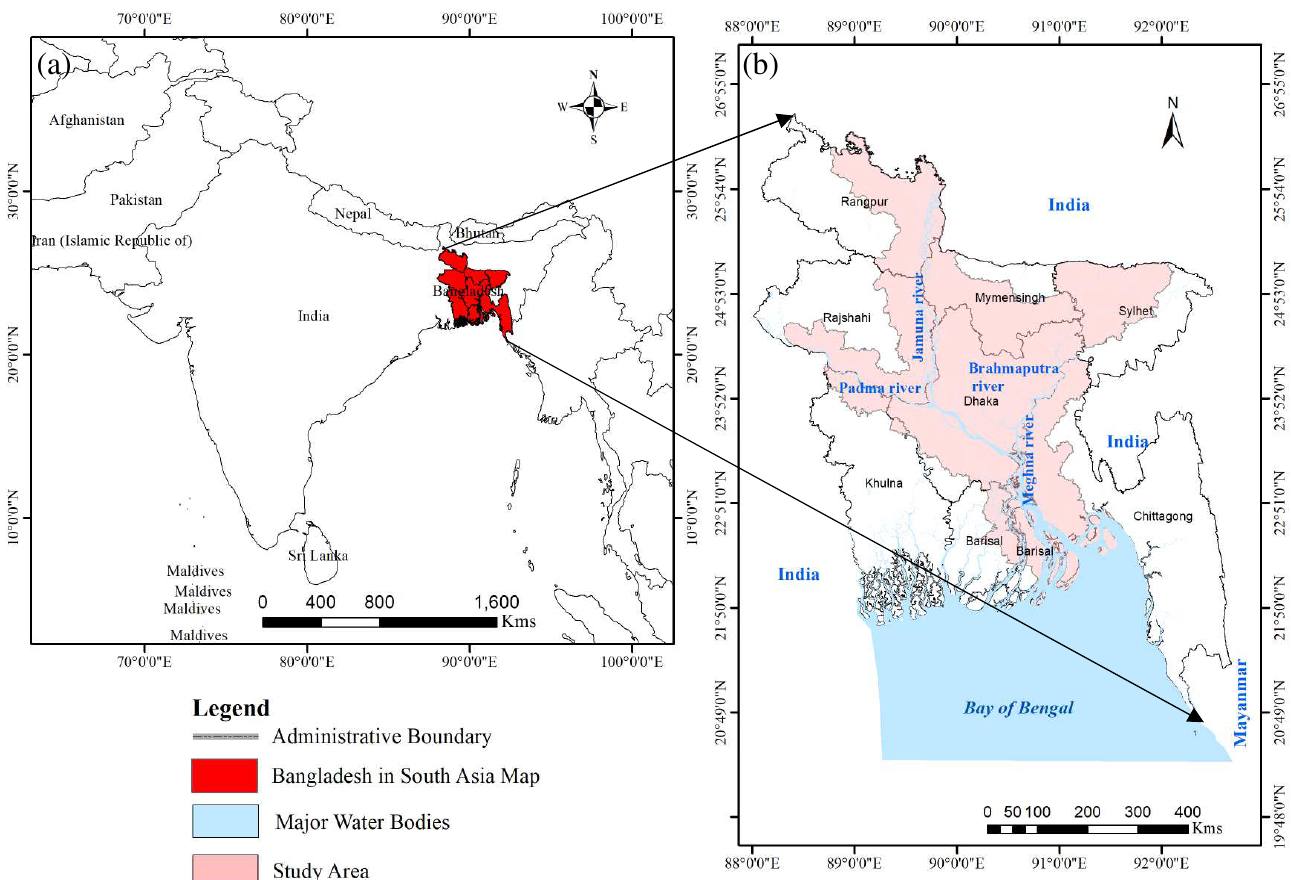
Figure 1. Geographical extent of the study area in Bangladesh. ( a ) Location of the Bengal delta on the South Asia map. ( b ) River distribution flow from north to south toward the Bay of Bengal.